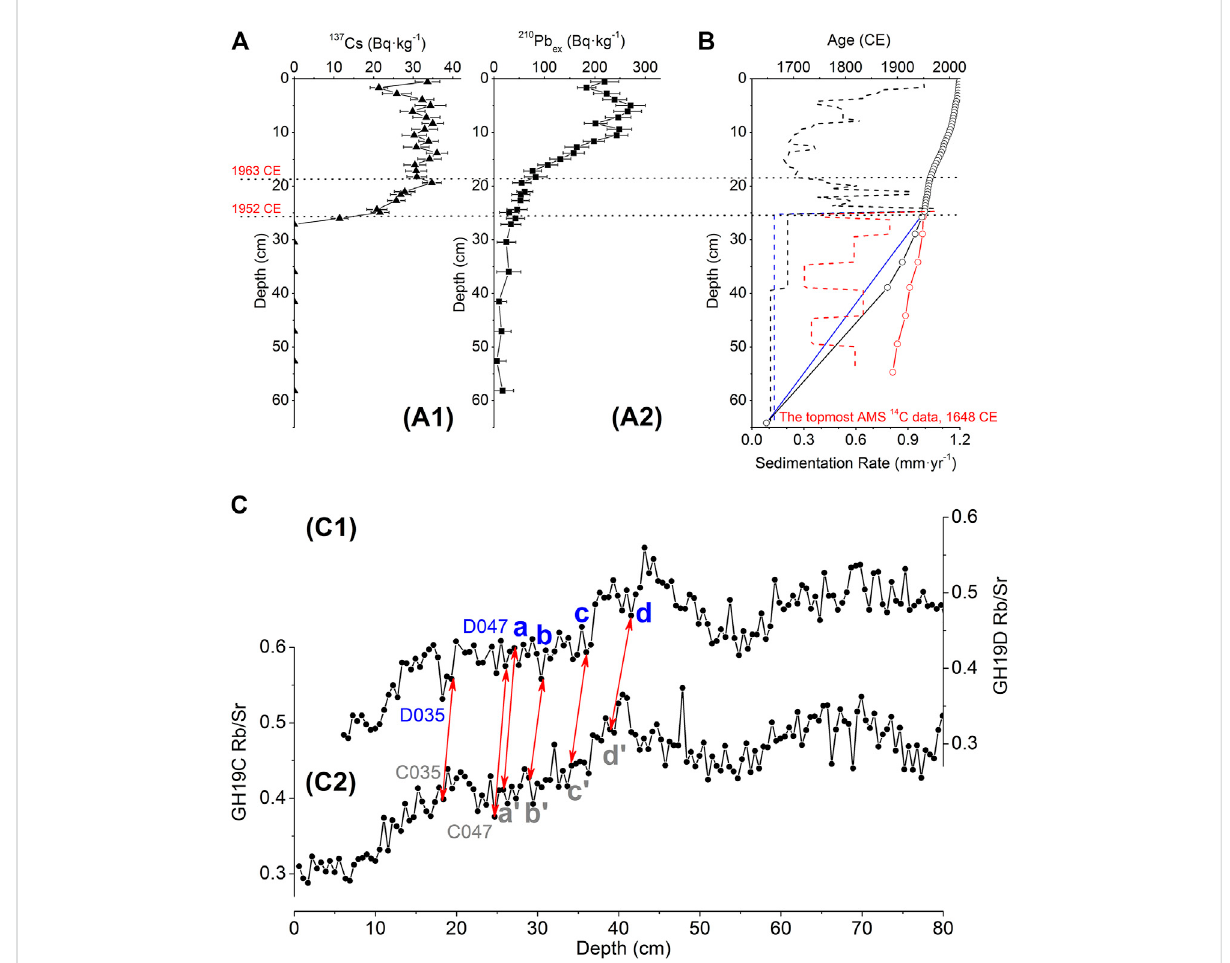
FIGURE 4 (A) Changes in (A1) 137 Cs and (A2) 210 Pb ex activities versus depth in core GH19D. Red text indicates the 1963 and 1952 CE 137 Cs marker. The grey error bars indicate standard deviation (s. d.). (B) Age-depth plots of GH19C-J obtained by Method I (red), II (blue) and III (black), the small circles are chronological control points. The dashed lines of different colors are plots of sedimentation rate versus depth obtained by the corresponding age- depthplotsofthesamecolor. (C) Rb/Srratiosversusdepthforcores (C1) GH19Dand (C2) GH19Candtheirchronologicalcorrespondence.The blue text indicates samples with absolute dating data, the grey text indicates samples with relative dating data, and red double arrows indicate the correspondence between the dating points. The a – a ’ , b – b ’ , c – c ’ , d – d ’ (the numbers of these samples are D049 – C049, D055 – C055, D065 – C065, D075 – C074, respectively) are the correspondence of age data obtained by Method